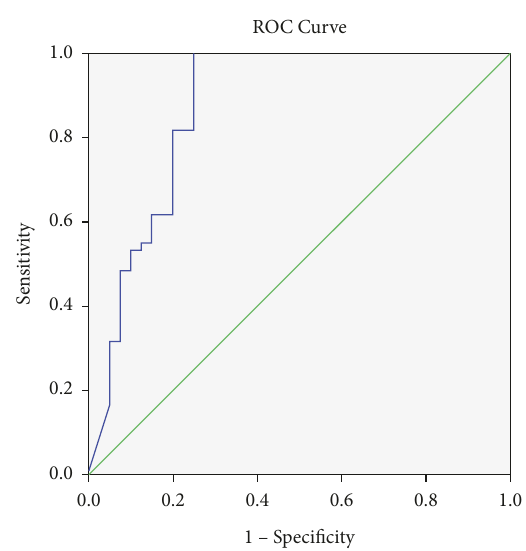
Figure 4: ROC bacteria